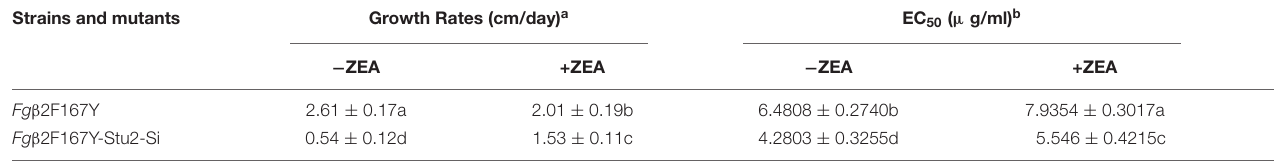
TABLE 3 | Hyphal growth rate and sensitivity of Fg β 2F167Y and Fg β 2F167Y-Stu2-Simutant to MBC ∗ on PDA with or without 30 µ M zearalenone (ZEA). Strains and mutants